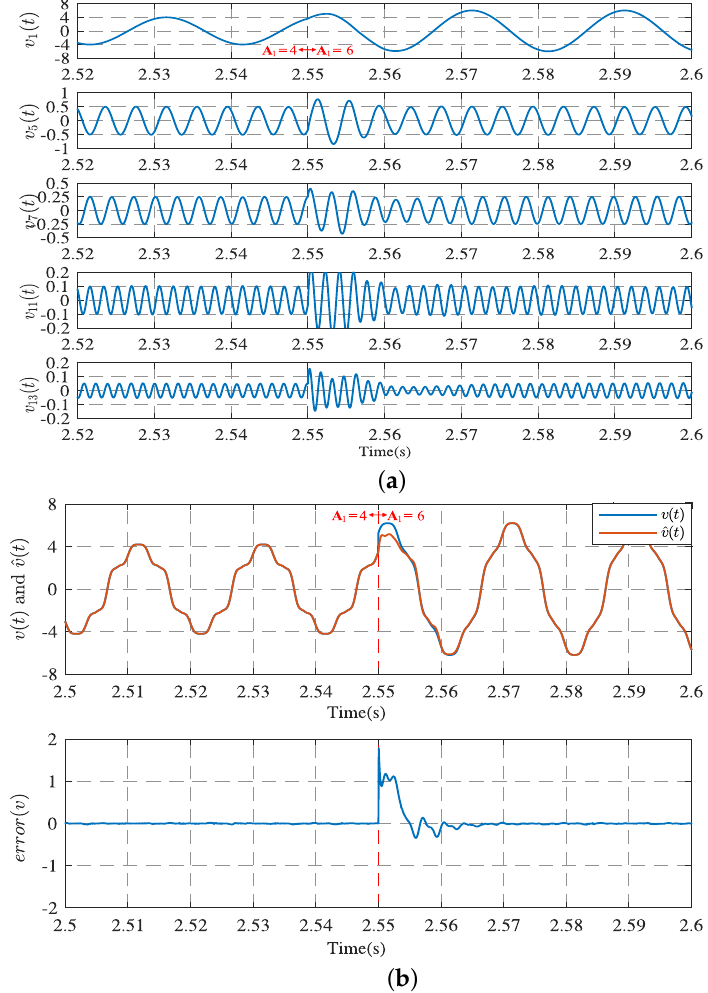
Figure 13. Experimental results: ( a ) The effect of extracting each harmonic after a jump in the fundamental amplitude of the input signal. ( b ) Comparison of the results of the observer with the real signal and the error